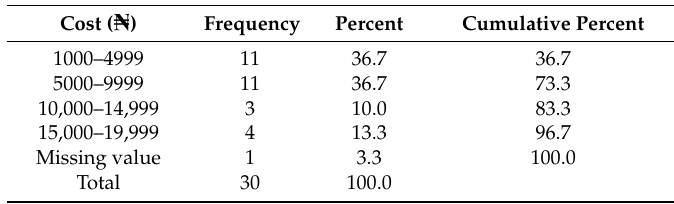
Table 2. Monthly expenditure on energy.